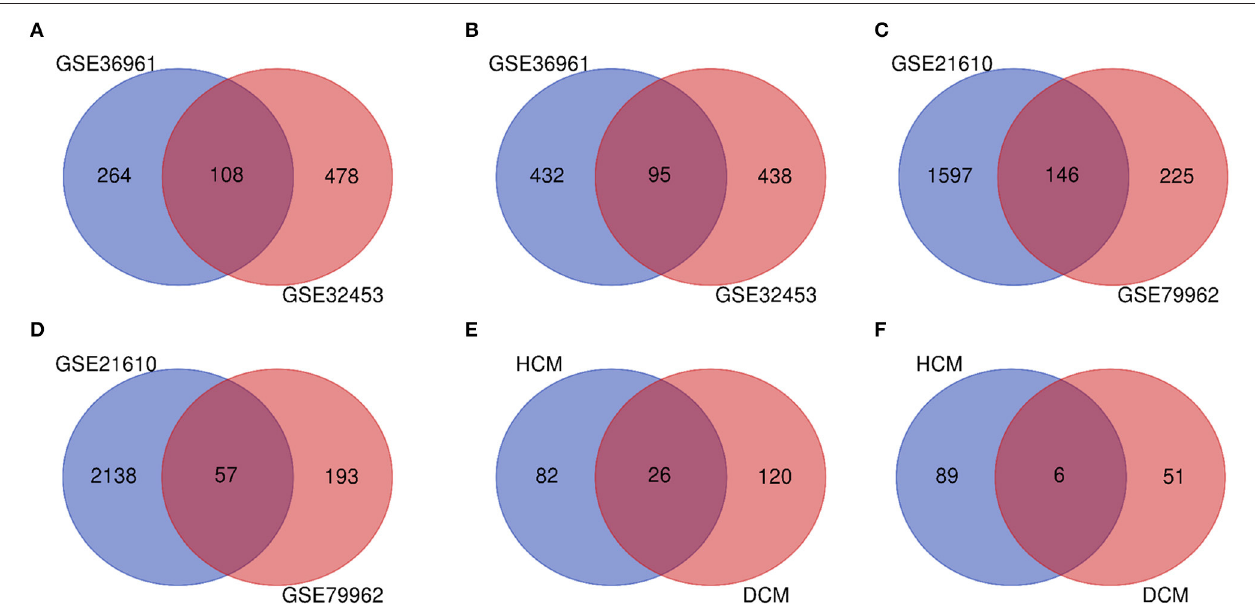
FIGURE 3 | (A) Venn diagram of the 108 communal upregulated differentially expressed genes (DEGs) in HCM. (B) Venn diagram of the 95 communal downregulated DEGs in hypertrophic cardiomyopathy (HCM). (C) Venn diagram of the 146 communal upregulated DEGs in dilated cardiomyopathy (DCM). (D) Venn diagram of the